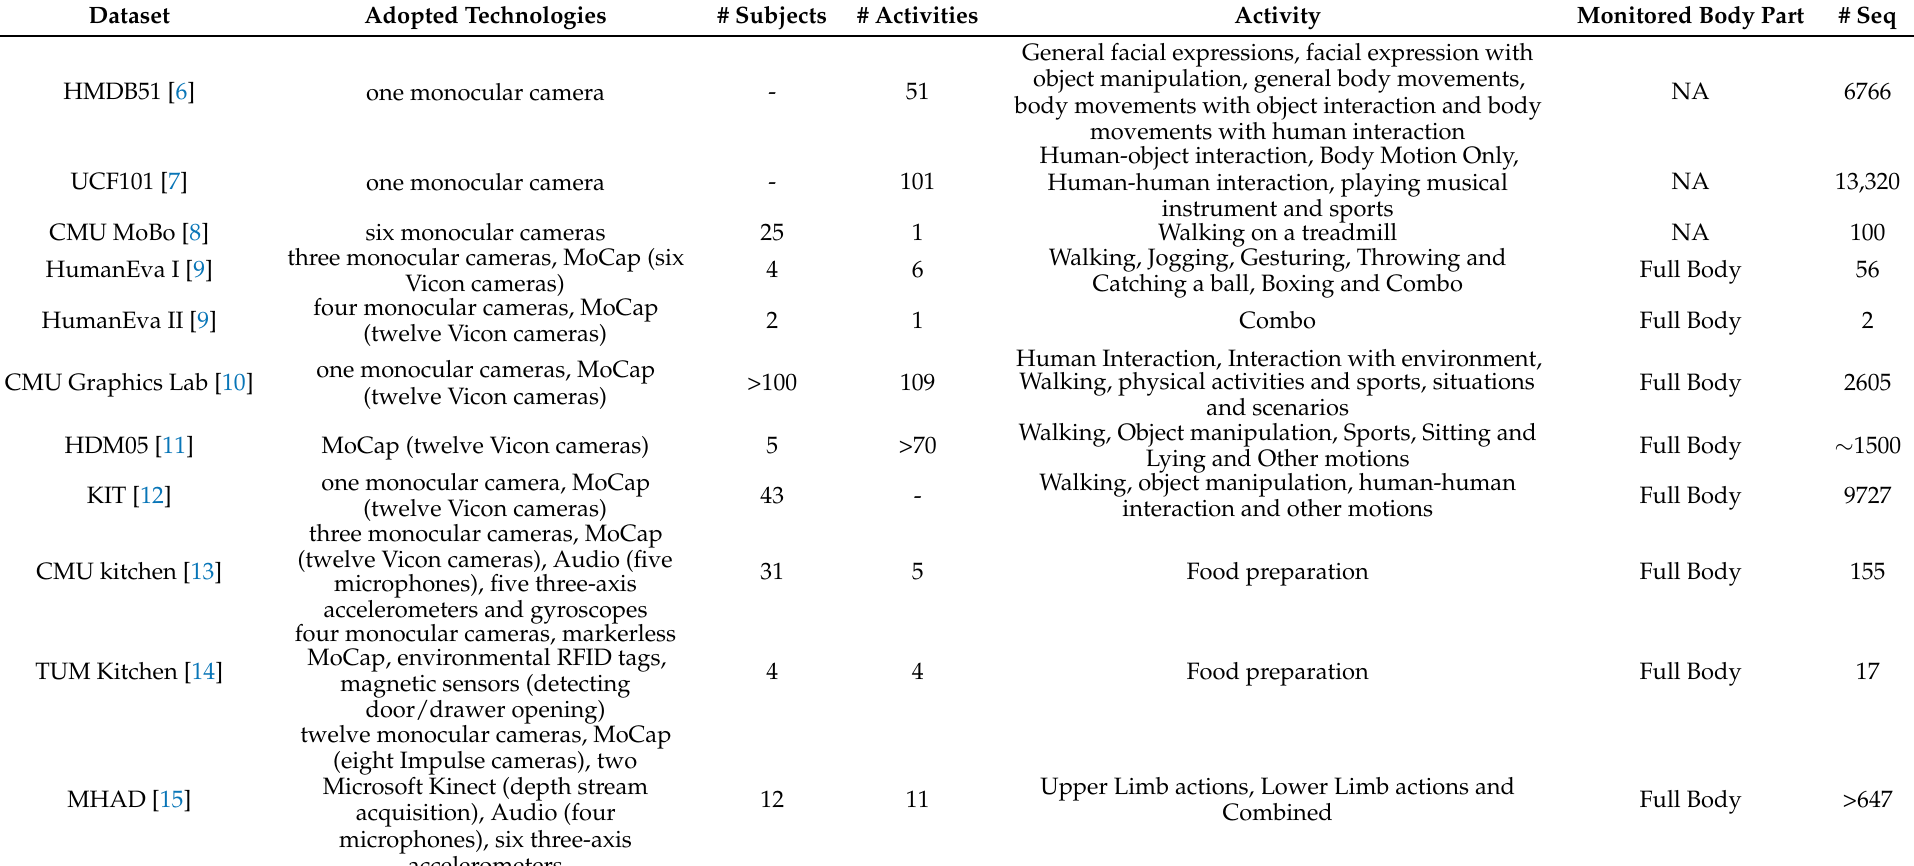
Table 1. Overview of human motion datasets available in the literature. The table lists the technologies used in the dataset building. In the “ Monitored Body Part ” column, NA stands for “Not Applicable” since those datasets do not provide Motion Capture